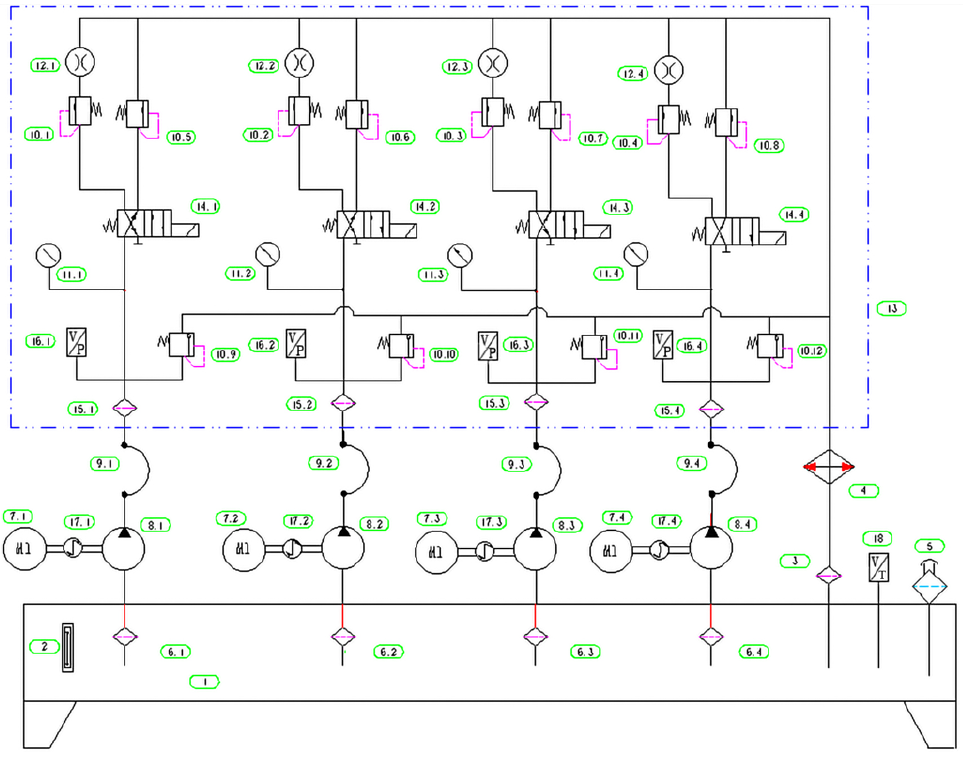
Figure 4. Hydraulic system schematic of gear pump life-cycle test bed: 1—Tank; 2—Liquid ther- mometer; 3—Return oil filter; 4—Forced-air cooler; 5—Air filter; 6—Self suction oil filter; 7—Electric motor; 8—Gear pump; 9—High-pressure hose; 10—Relief valve; 11—Pressure gauge; 12—Flow meter; 13—Valve block; 14—Electromagnetic reversing valve; 15—High pressure filter; 16—Pressure sensor; 17—Torque-speed transducer; and 18—Temperature